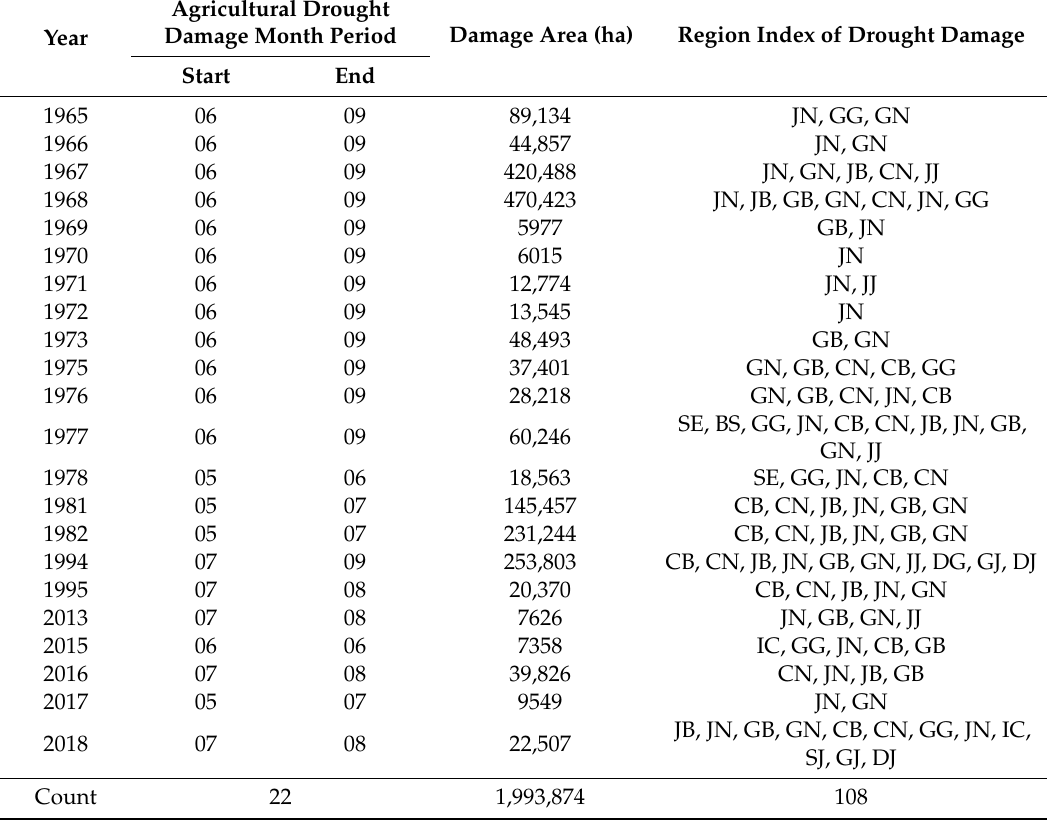
Table 2. Damage from agricultural droughts by year.